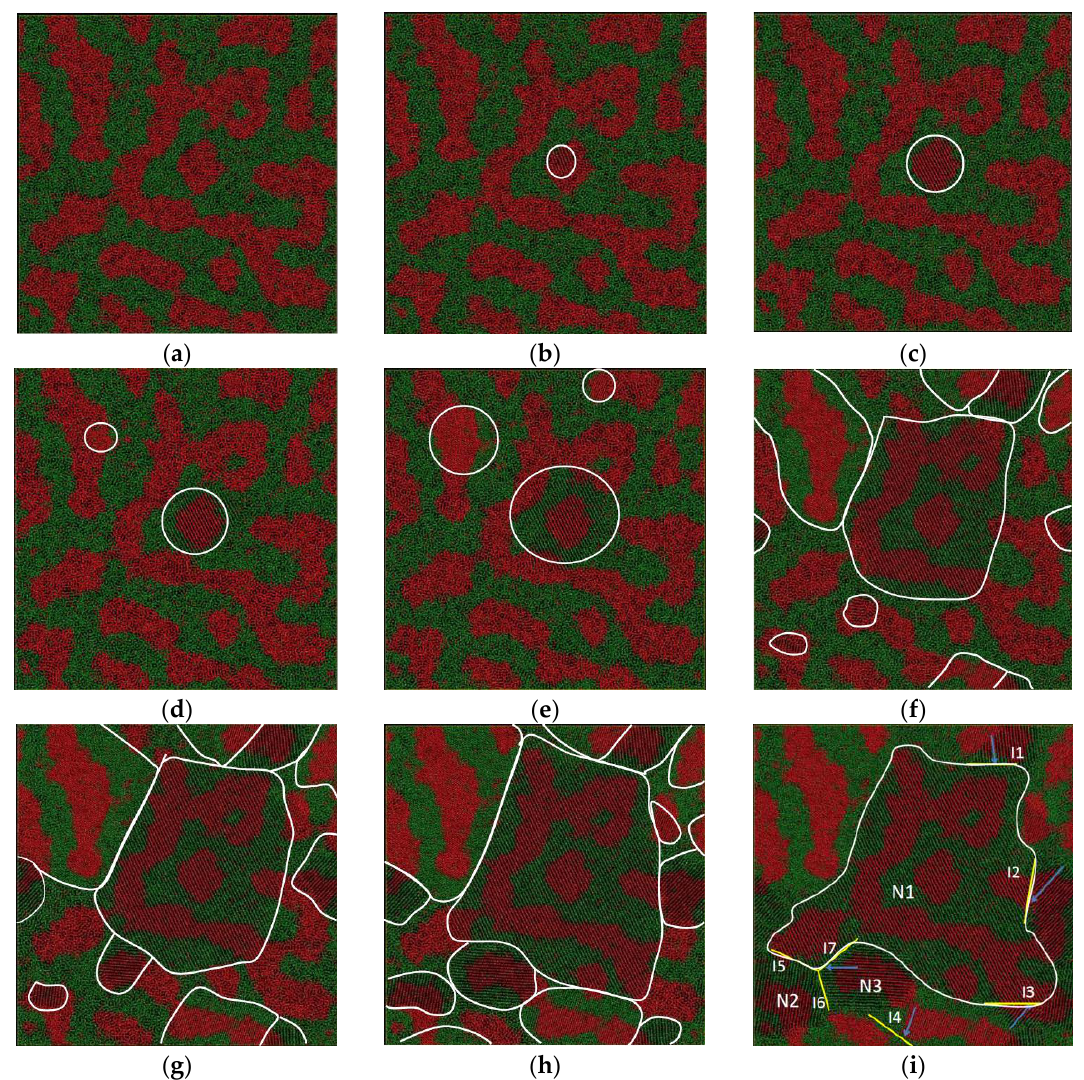
Figure 7. Atom snapshot of Fe 50 Cu 50 during the crystallization process at the cooling rate of 6.4 × 10 11 K/s. ( a – i ) correspond to the atomic configuration at temperature of 1180 K, 1170 K, 1160 K, 1150 K, 1140 K, 1110 K, 1100 K, 1090 K, 1060 K, respectively.